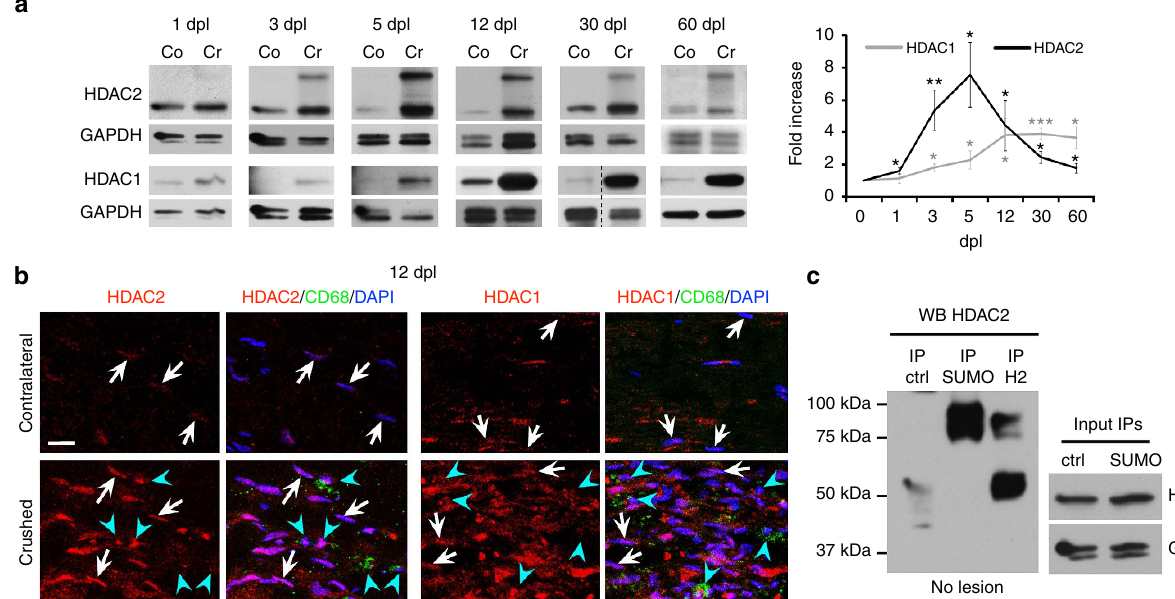
Figure 1 | HDAC1/2 are robustly upregulated in SCs after lesion. ( a ) Western blots of HDAC2 and HDAC1 in lysates of crushed (Cr) and contralateral (Co) nerves of adult mice at 1 dpl ( n ¼ 5), 3 dpl ( n ¼ 5), 5 dpl (HDAC2, n ¼ 6; HDAC1, n ¼ 7), 12 dpl (HDAC2, n ¼ 6; HDAC1, n ¼ 8), 30 dpl (HDAC2, n ¼ 6; HDAC1, n ¼ 8) and 60 dpl ( n ¼ 6), and quantification normalized to GAPDH and compared to Co ¼ 1, showing HDAC1/2 upregulation after lesion. Of note: both bands detected by the HDAC2 antibody were quantified and added together in the graph. ( b ) Co-immunofluorescence of HDAC2 or HDAC1 (red) with CD68 (gree n ¼ macrophages) and DAPI labelling (blue ¼ nuclei, overlay appears pink) at 12 dpl, showing upregulation in SCs (CD68-negative cells with elongated nuclei, white arrows) of crushed compared to contralateral nerves. Note that macrophages (CD68-positive cells, blue arrowheads) express variable levels of HDAC1 and HDAC2. Scale bar, 10 m m. ( c ) Denaturing IP of SUMO-1, HDAC2 (H2) or control Flag (ctrl) in unlesioned (no lesion) adult mouse sciatic nerve lysates, and western blot of HDAC2, showing that the B 75kDa band detected by the HDAC2 antibody corresponds to a SUMOylated form of HDAC2. HDAC2 and GAPDH western blots on lysates used for IP show the inputs. Representative photos of three independent experiments are shown. One-tailed (HDAC2, 12 dpl and 60 dpl; HDAC1, 5 dpl) or two-tailed Student’s t -tests, unpaired (HDAC2: 3 dpl) or paired, P